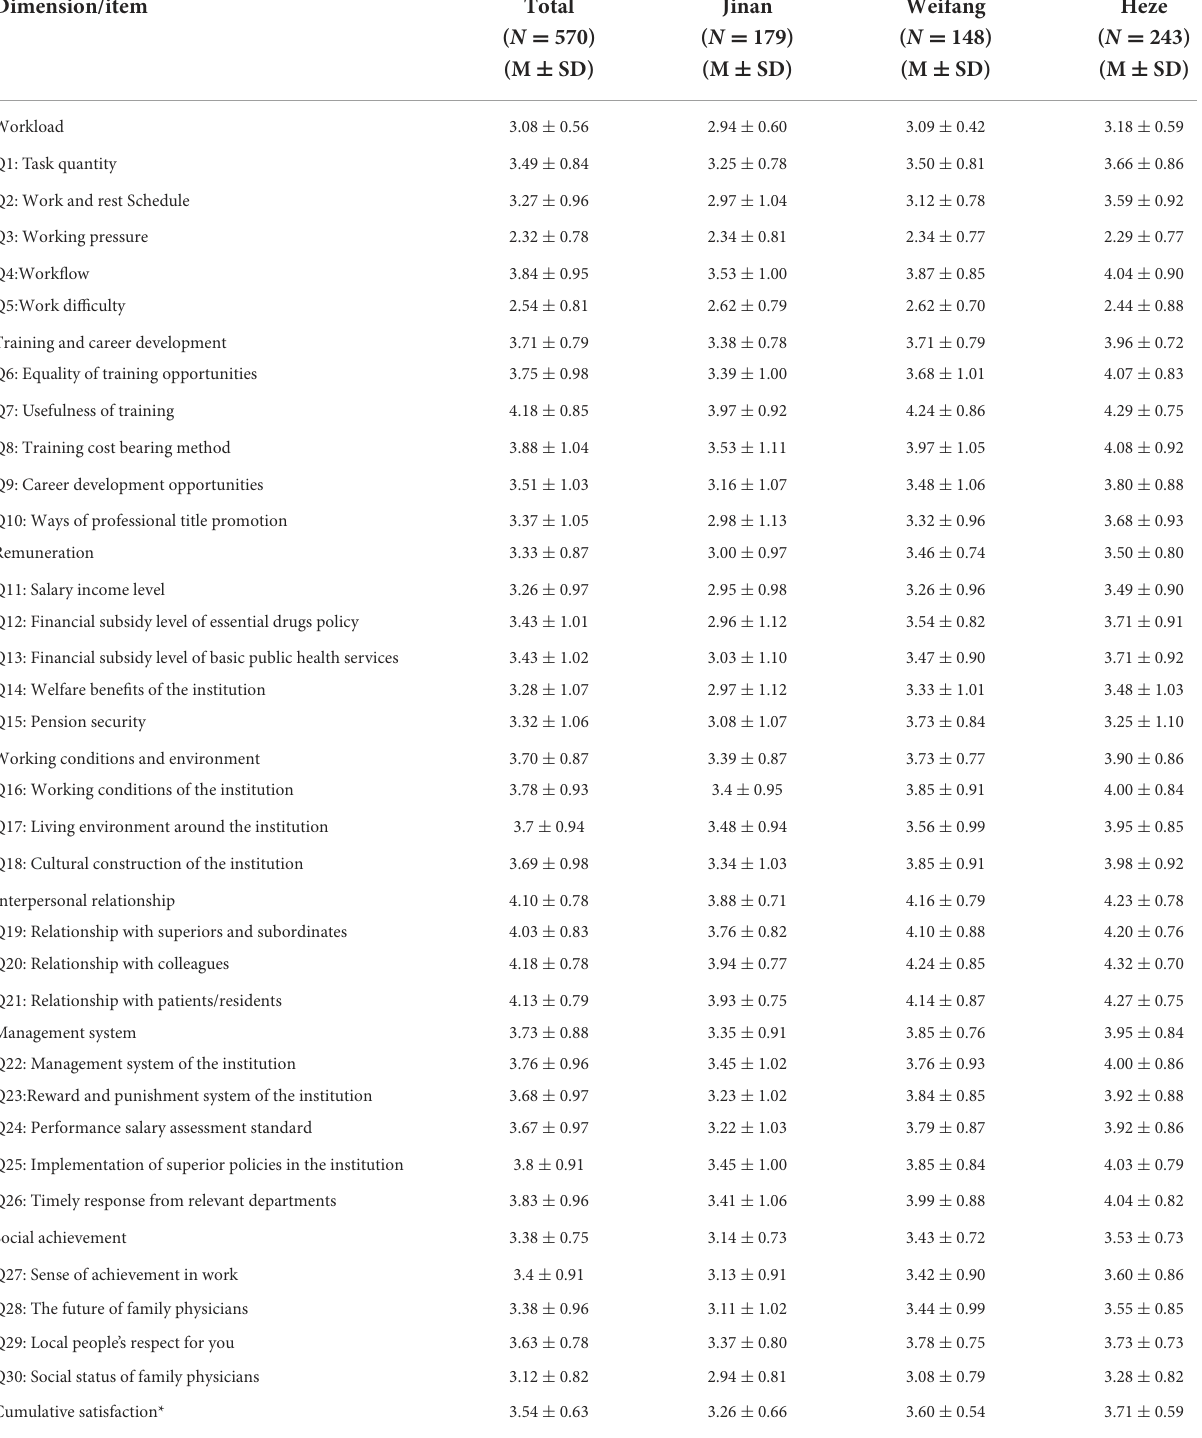
TABLE 2 Job satisfaction scores of